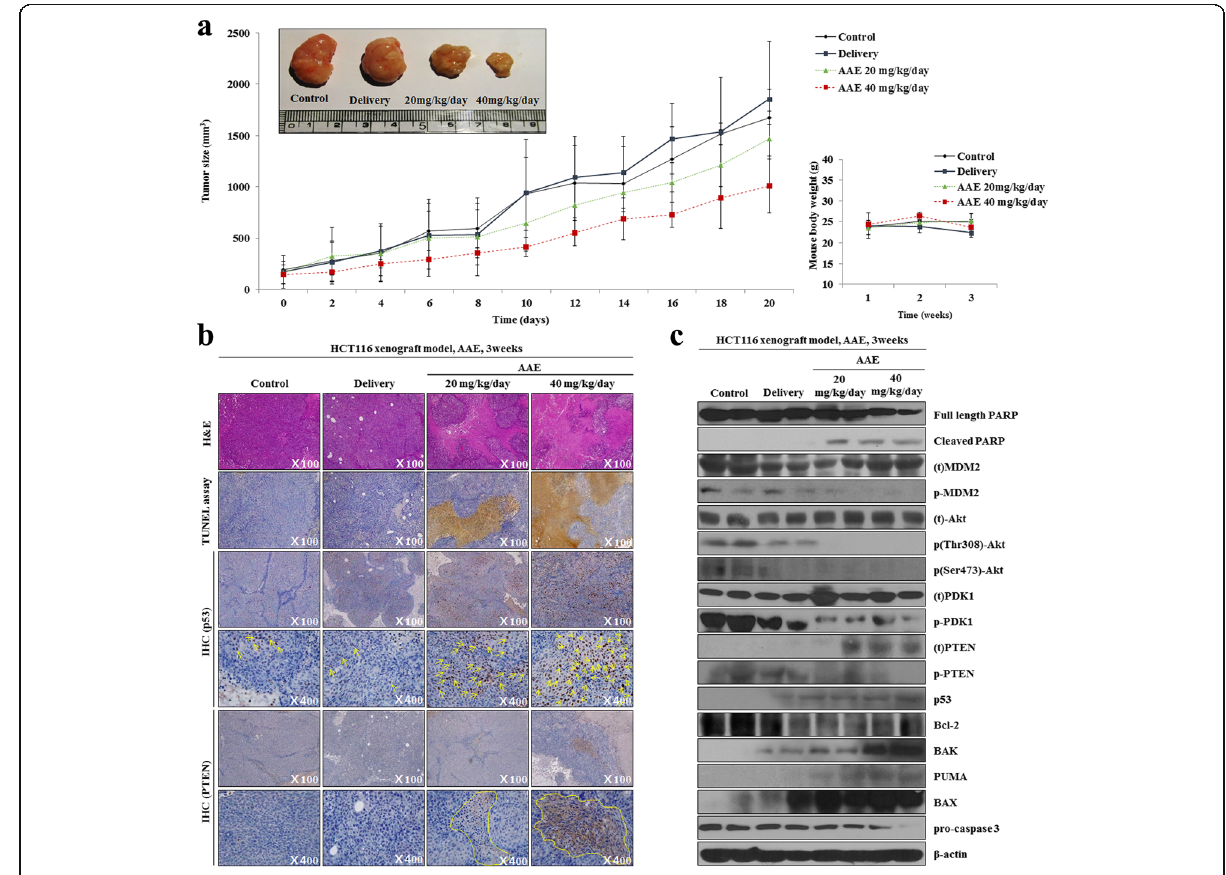
Fig. 6 AAE induced apoptosis through regulated mitochondria signaling pathways in HCT116 Xenograft model. a Tumor size and body weight of HCT116 Xenograft model mouse. AAE direct inject to tumor and tumor size were redialed each 2 day and tumor image. b Histological experiments of tumor tissue. H&E staining, TUNEL assay and Immunohistochemical (IHC) assay were were performed at 21 day. The arrow and around indicate that specific proteins were activated by AAE treatment. c The expression of PTEN, PDK1, Akt (Thr308 and Ser473), MDM2, p53, PUMA,Bcl-2, pro-caspase3 and the activation of Bax, Bak and cleaved PARP were analyzed by western blot